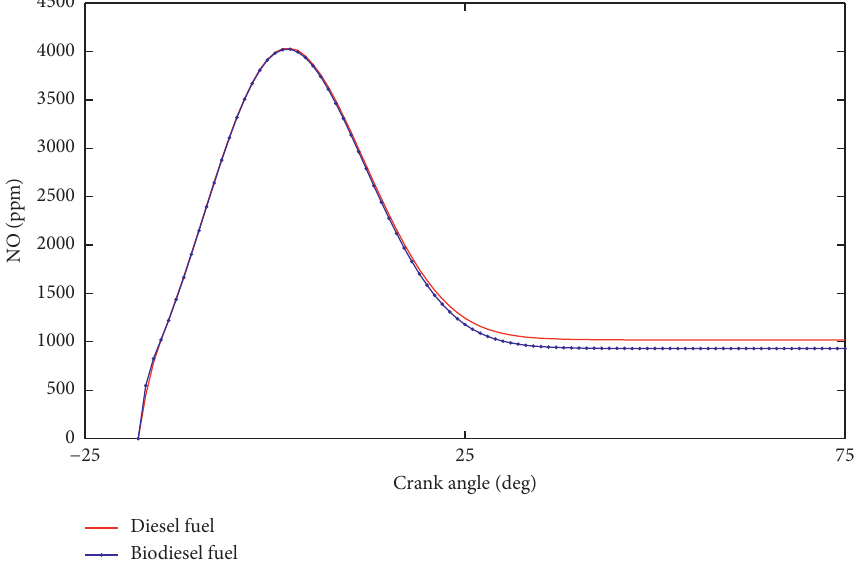
Figure 12: NO concentration comparison of biodiesel and diesel